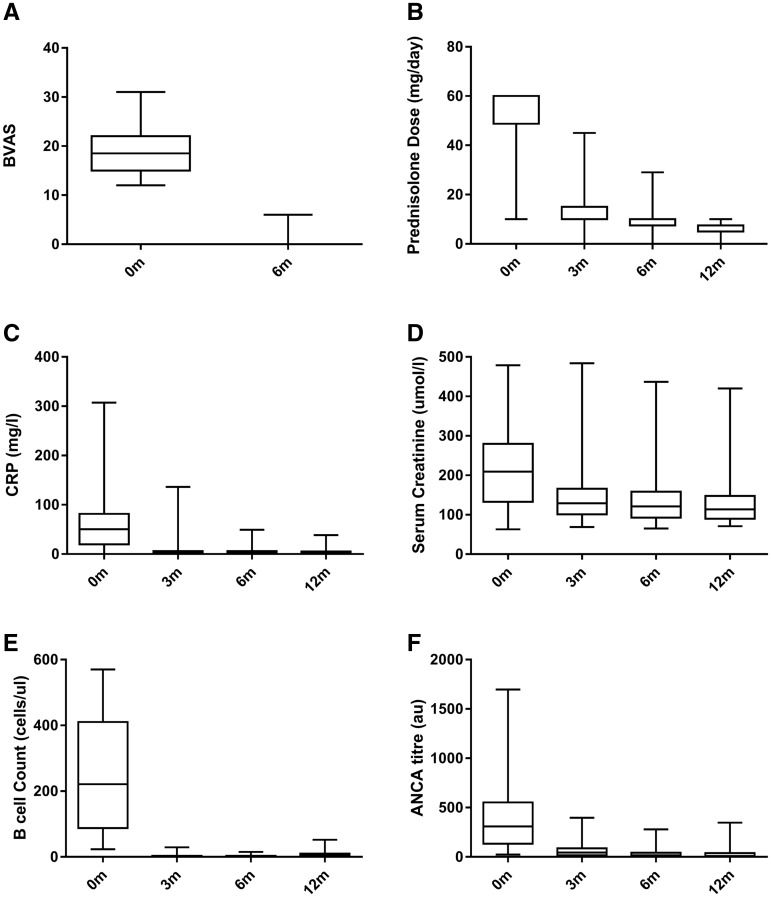
Early disease response at 6 and 12 months. (A) BVAS at 0 and 6 months. (B) Oral prednisolone dose (mg/day) during the first year of therapy. Fourteen patients received pulsed intravenous methylprednisolone prior to referral to our centre and in these cases the initial dose of oral prednisolone was reduced. (C) Sequential serum CRP (mg/L). D Serum creatinine (μmol/L). (E) Peripheral B lymphocyte count (cells/μL). (F) ANCA titres as determined by antigen specific assay (1F) at 3, 6 and 12 months. Box and whisker plots represent median (IQR) and range measurements.